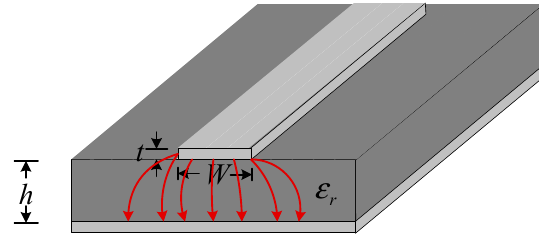
Figure 5. The illustration of the microstrip line.